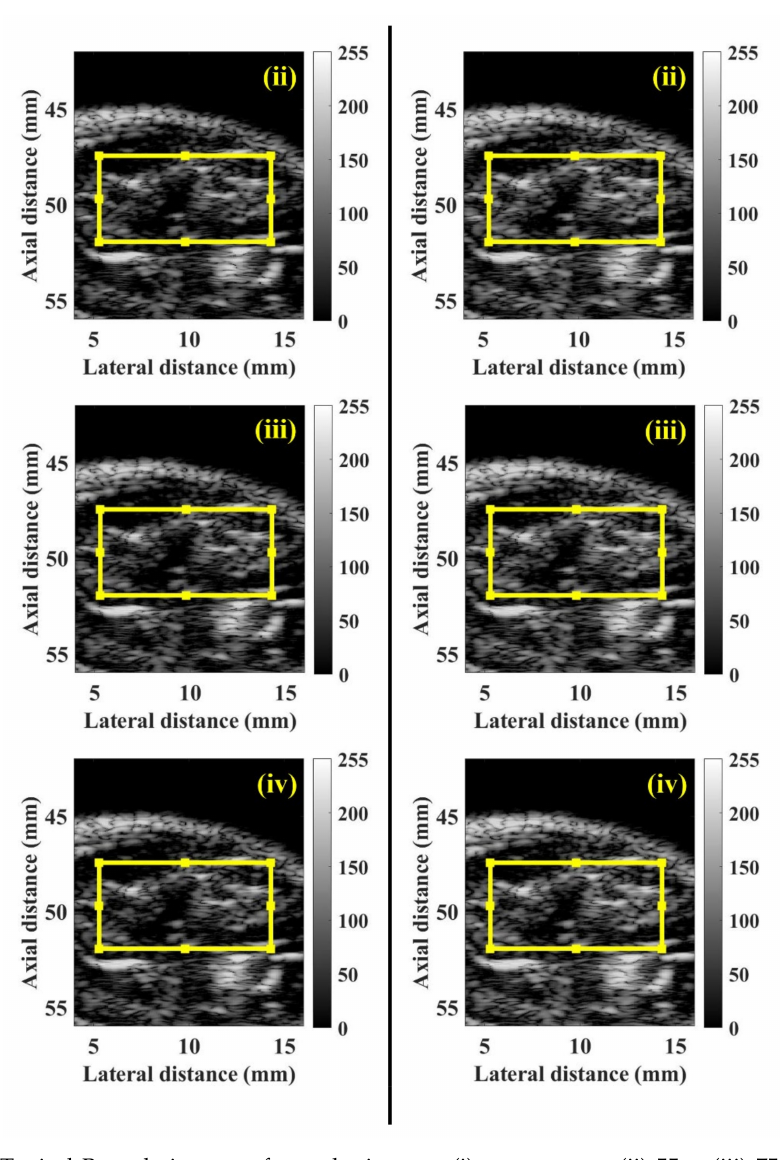
Figure 9. Typical B-mode images of muscle tissue at (i) pre-contrast, (ii) 55 s, (iii) 75 s, and (iv) 110 s, following UCAs administration corresponding to the incidence of ( a ) 2.86 and ( b ) 4.37 MPa acoustic pressures. The region of interest (ROI) is indicated by the yellow rectangular area.